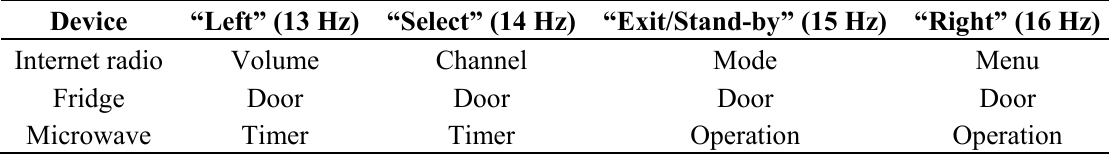
Figure 8. Hybrid Gaze-SSVEP BCI with sequential processing. The eye tracker acts as a selector which activates the SSVEP system. Table 1. Quick access to submenus.